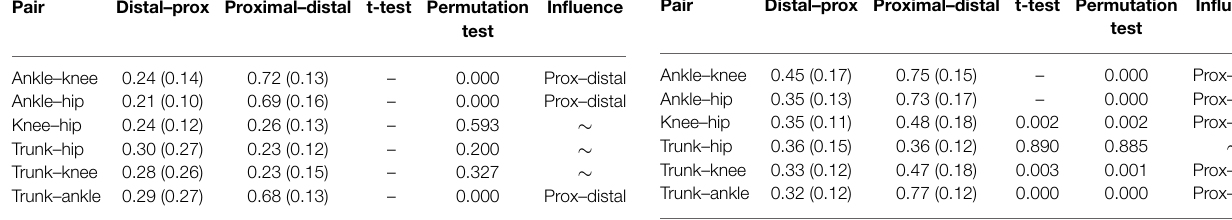
TABLE 2 | Average values (SD) calculated from causal influence in the frontal plane kinematic data during running. Influence test